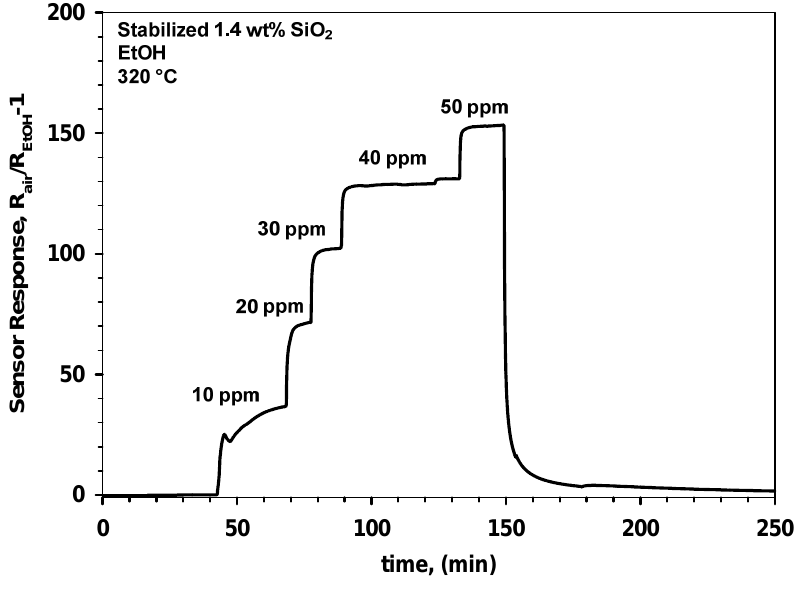
Figure 8. Response to increasing EtOH concentrations in dry air of a gas sensor made of 1.4 wt% SnO -SiO nanocomposites upon stabilization by sintering for 12 h at 600 2 2